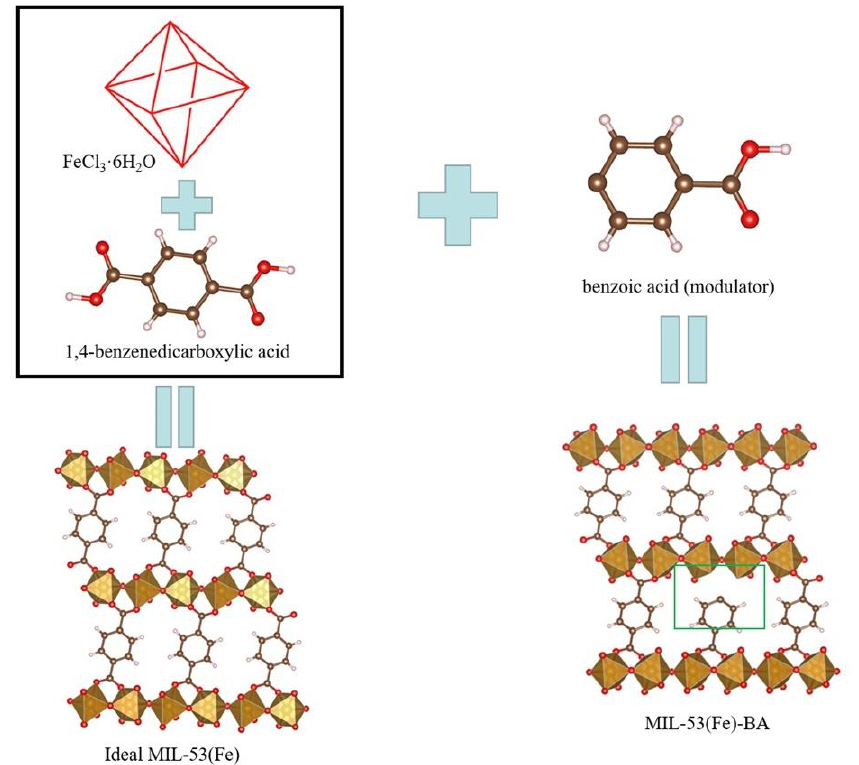
Figure 3. Scheme for the synthesis of defective MIL-53(Fe)-BA using benzoic acid as modulator.